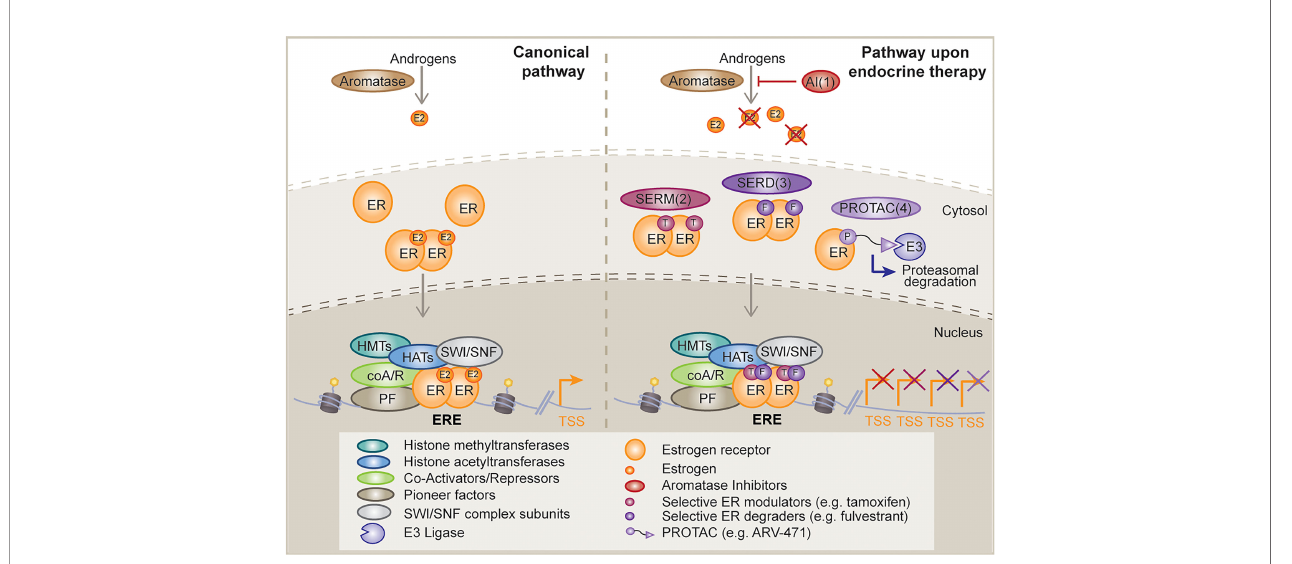
FIGURE 1 | Mechanism of action of classical and novel endocrine therapies. Schematic diagram depicting, on the left, the canonical estrogen receptor (ER) activating signaling cascade and potential downstream interactor types; and on the right, the different mechanisms of disruption of this signaling pathway upon distinct endocrine therapy strategies, such as, aromatase inhibitors (AI, 1), selective ER modulators (SERMs, 2), selective ER degraders (SERDs, 3) and proteolysis targeting chimeras (PROTACs, 4). E2, estrogen; ER, estrogen receptor; T, tamoxifen; F, fulvestrant; E3, E3 ligase; HMT, histone methyltransferase; HAT, histone acetyltransferase; coA/R, co-activator/repressor; PF, pioneer factor; TSS, transcription start site; ERE, estrogen response